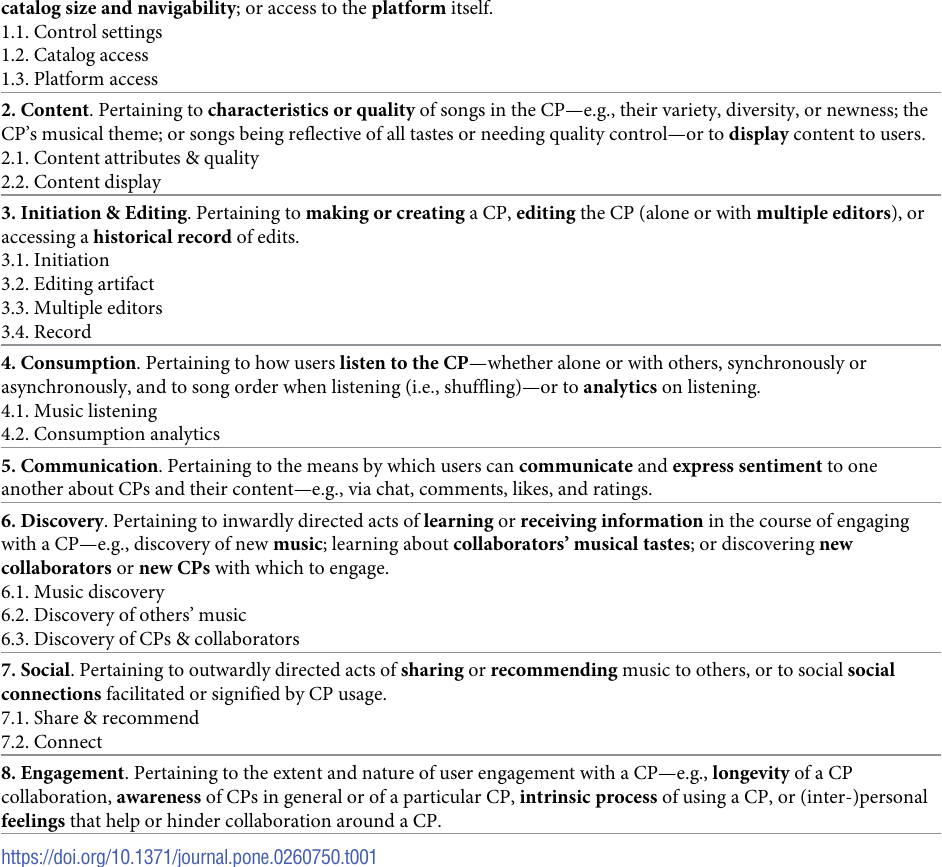
Table 1. Codebook of Critical CP Factors, derived from thematic analysis of free-text responses delivered by CP users regarding which aspects of CPs are most useful and important, and which are desired or lacking. 1. Access . Pertaining to platform affordances for accessing and editing CPs: Settings to control CP access ; music catalog size and navigability ; or access to the platform